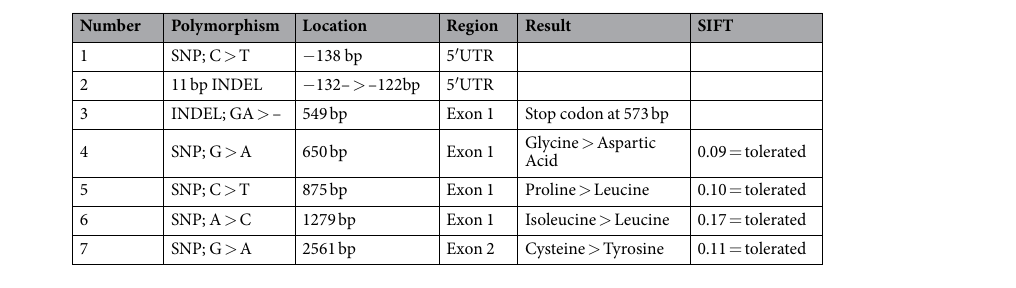
Table 3. Polymorphisms in Sobic.006G067700.